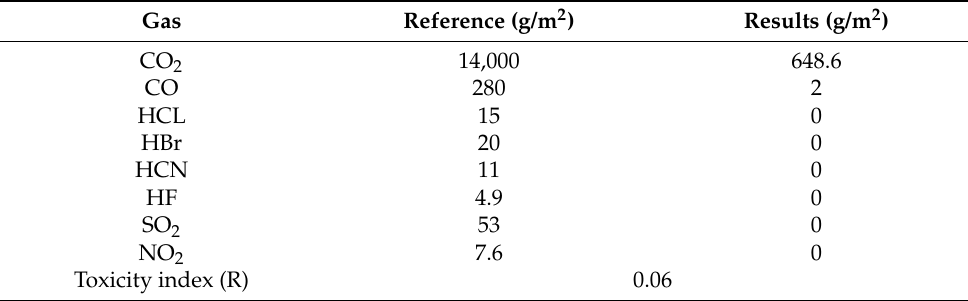
Table 2. Reference toxicity values for gases and toxicity test